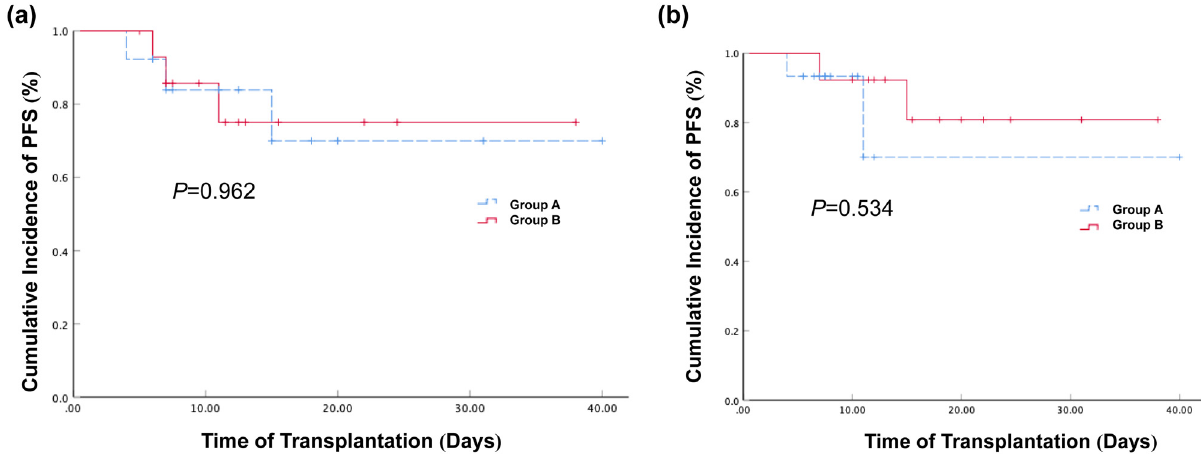
Figure 4: E ff ect of LOHC duration and onset time on the cumulative incidence of PFS. ( a ) The cumulative incidences of PFS in patients with LOHC duration for more than 19 consecutive days and patients with LOHC duration for less than 19 days after haplo - PBSCT were 69.9% ( 95% CI: 39 – 100.8% ) and 75% ( 95% CI: 49.7 – 100.9% ) , respectively. The P value was 0.962. ( b ) The cumulative incidence of PFS in LOHC patients with LOHC median onset time for less than 33 days and longer than 33 days after haplo - PBSCT were 70% ( 95% CI: 29.2 – 110.8% ) and 80% ( 95% CI: 55.2 – 105.8% ) , respectively. The P value was